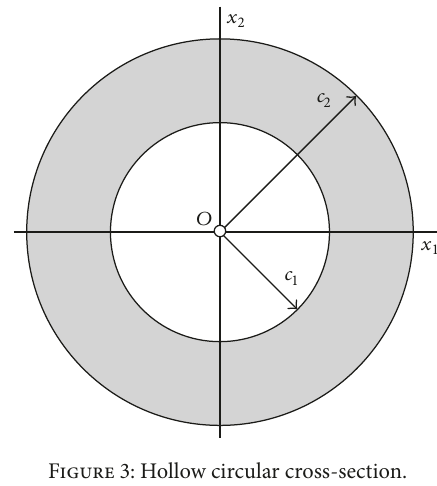
Figure 3: Hollow circular